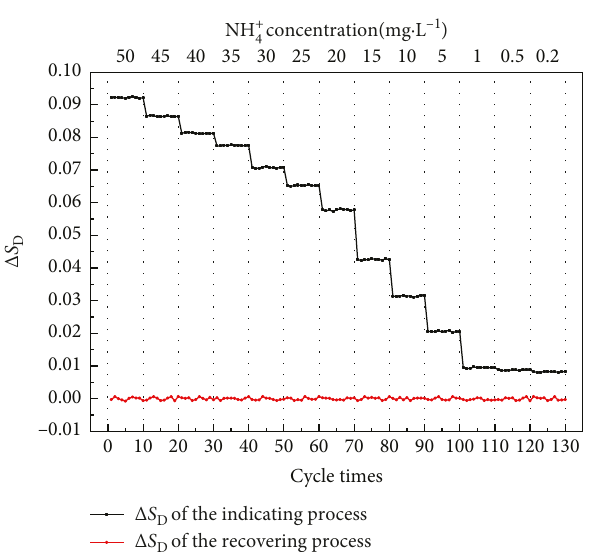
Figure 10: Δ S d of the indicating process and the recovering process for each